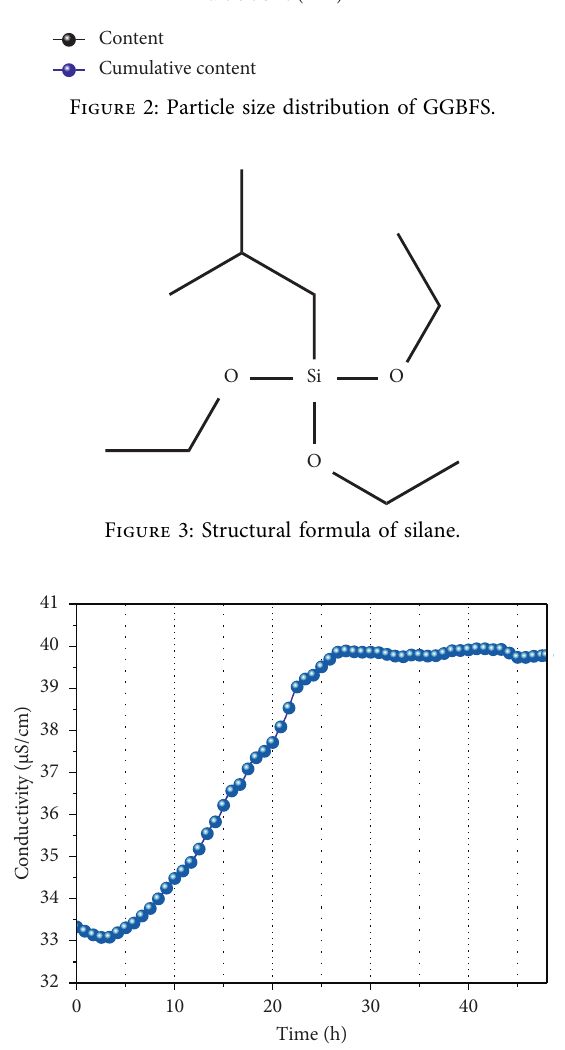
Figure 4: The variation of the conductivity of the silane solution in